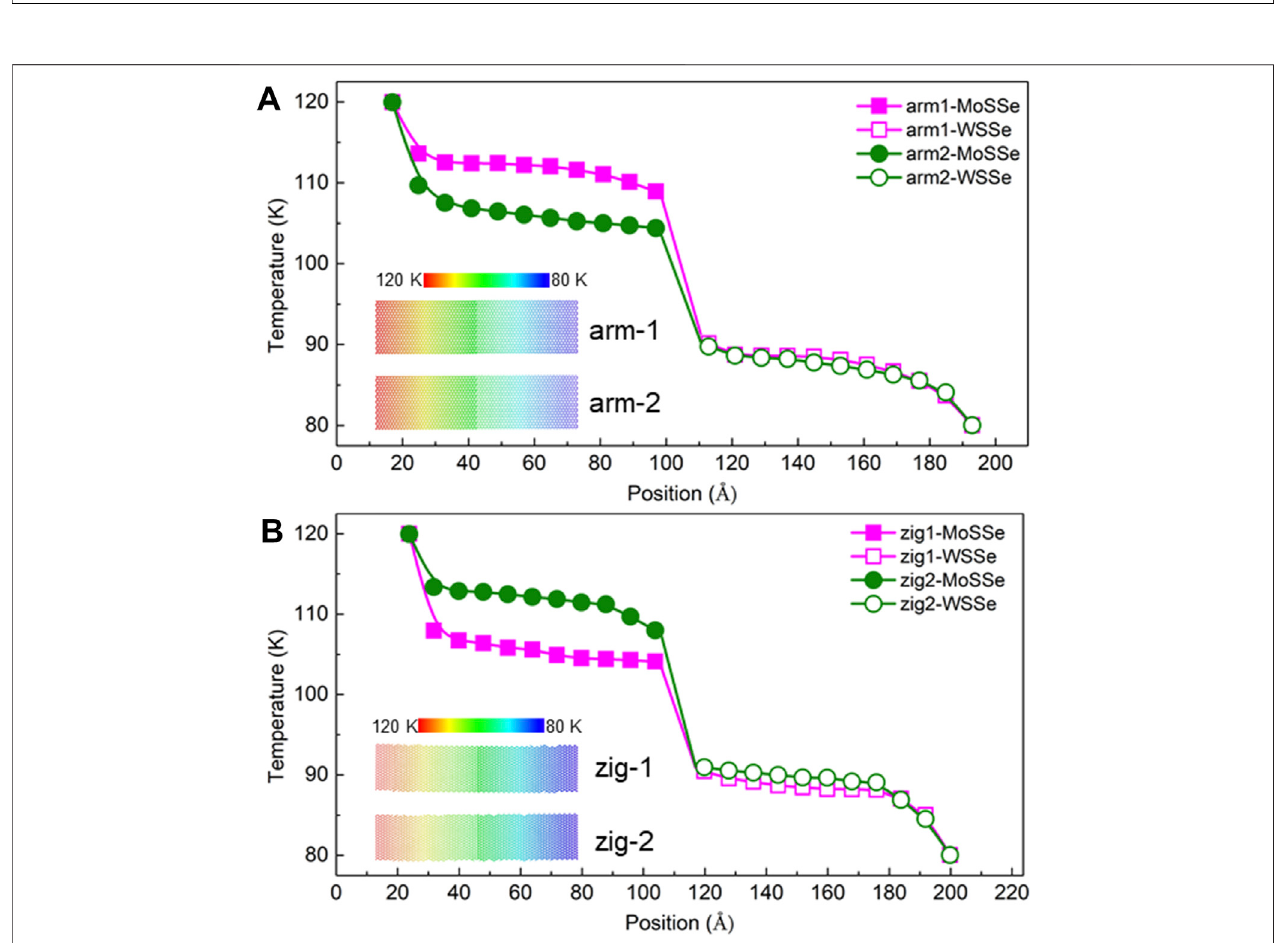
FIGURE 6 | Temperature pro fi les the (A) arm-1, (B) arm-2, (C) zig-1, and (D) zig-2 MoSSe/WSSe heterostructures.